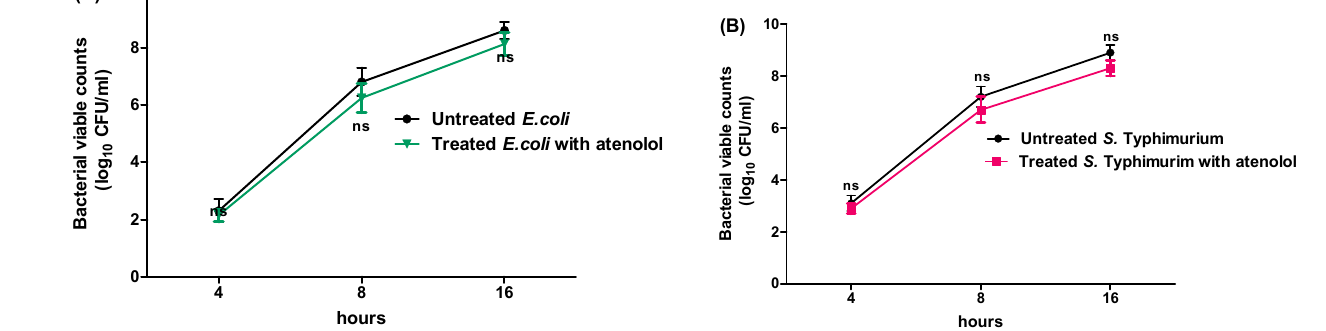
Figure 1. Effect of atenolol at sub-MIC on bacterial growth. ( A ) E. coli K-12, and ( B ) S. typhimurium were overnight cultured in the presence or absence of atenolol. There was no significant effect of atenolol on the growth. The experiment was performed in triplicate and results are expressed as the means ± standard deviation with p value < 0.05 considered statistically significant.